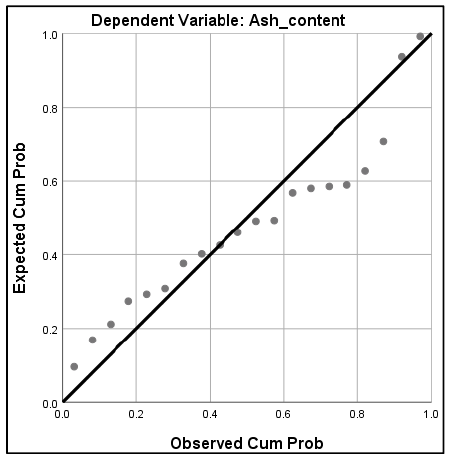
Figure 6. Normal P-P Plot of regression of the standardized residual of ash content (dependent Normal P-P Plot of regression of the standardized residual of ash content variable). (dependent